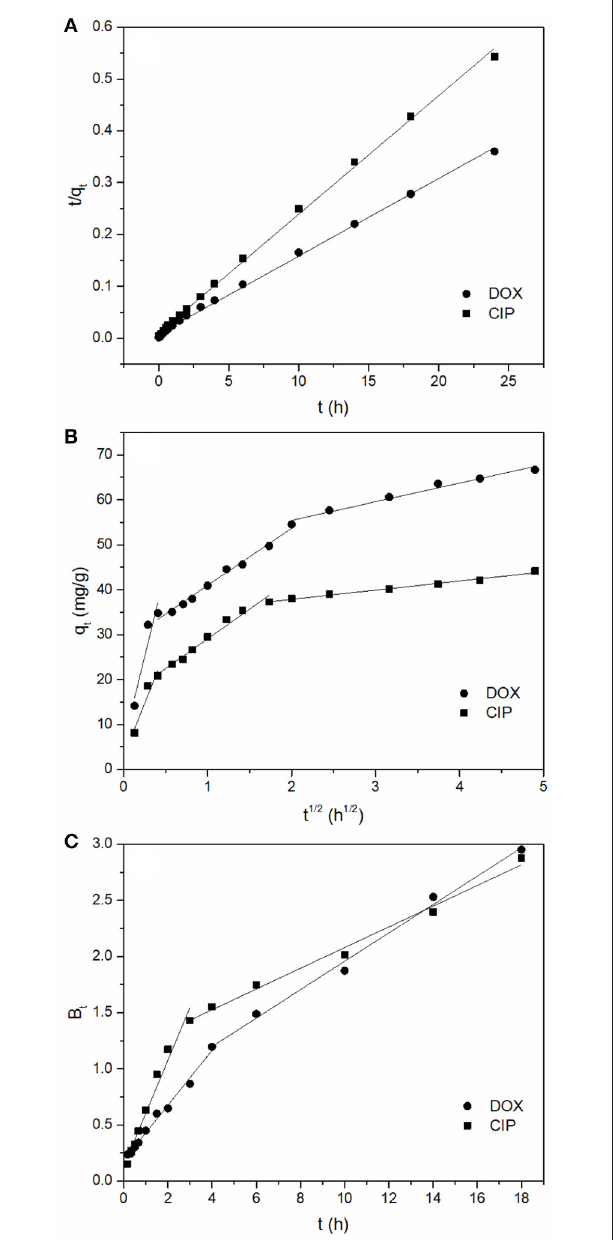
FIGURE 4 | (A) Pseudo-second-order plots for antibiotics adsorption, (B) Intra-particle diffusion plots for antibiotics adsorption, (C) Boyd plots for antibiotics adsorption (initial concentration = 40 mg/L; sorbent dose = 0.4 g/L; temperature = 298K; pH = 6).